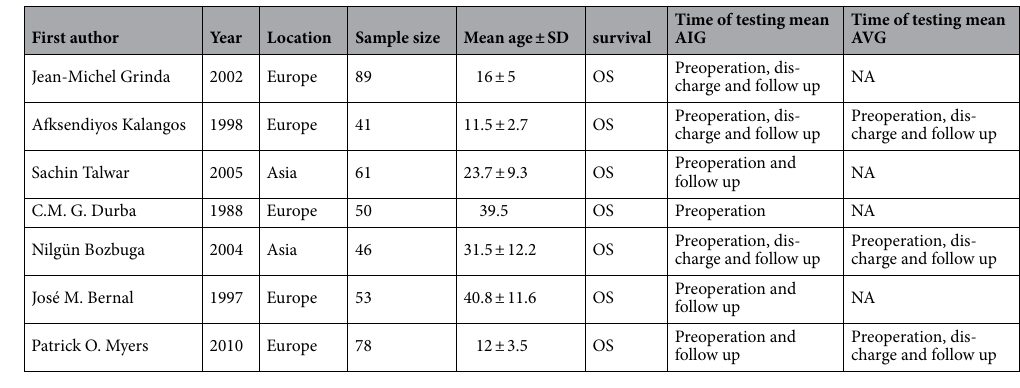
Table 1. Characteristics of the included studies. OS overall survival, AIG aortic insufficiency grade, AVG aortic valve gradient, NA not